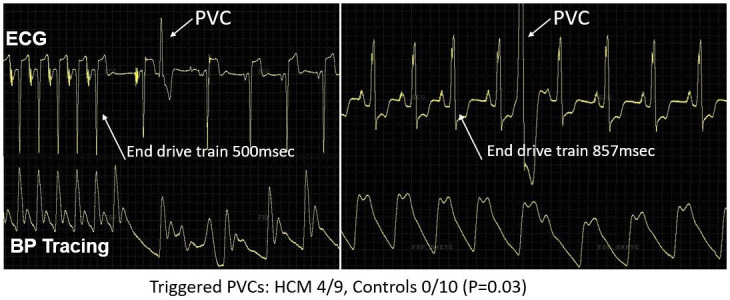
Following completion of drive train, two examples of triggered ventricular ectopy (premature ventricular contraction [PVC], arrow) in participants with hypertrophic cardiomyopathy.